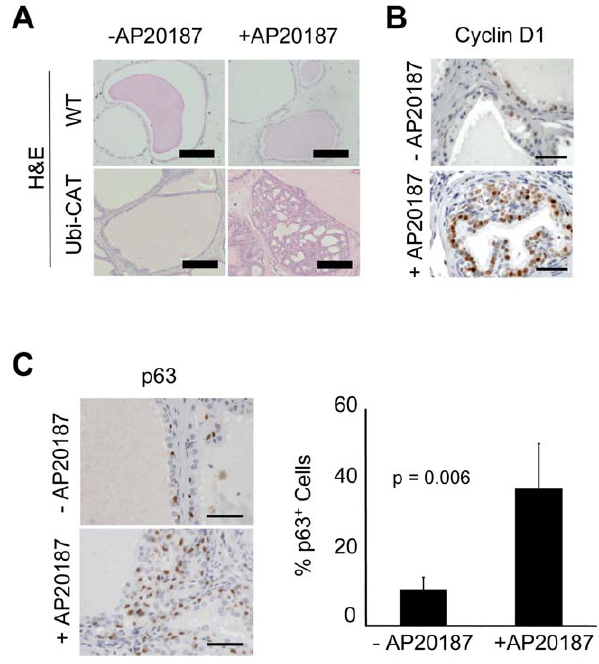
Figure 9. Activation of iLRP promotes prostate hyperplasia in the prostate reconstituted grafts. ( A ) H&E analysis of prostate grafts. Activation of iLRP5 for 8 weeks resulted in formation of hyperplastic acini in prostate grafts. Bar=100 m m. ( B ) Immunostaining of prostate grafts using cyclin D1 antibody. Bar=50 m m ( C ) Immuno- staining of prostate grafts using p63 antibody, Activation of iLRP5 resulted in over two-fold increase in the number of p63 + cells. Data representative of 9 + CID and 9 2 CID grafts. Bar=50 m